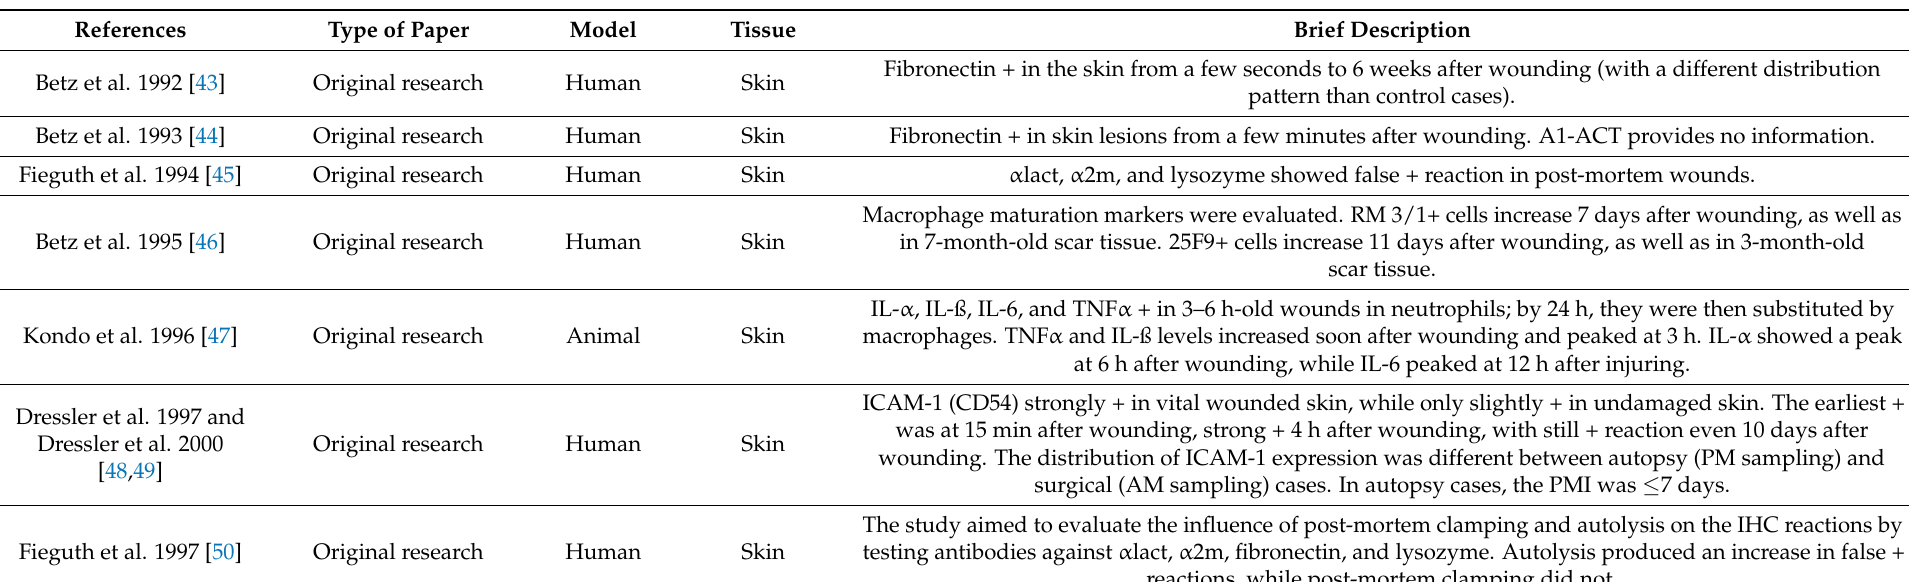
Table 2. The results of our review on immunohistochemical studies on wound vitality (84 articles). * These studies included different kind of analysis to investigate the differential protein expression in tissues, and they have been included in both the relative tables. + indicates positive/positivity; α 7nAChR, α 7 nicotine acetylcholine receptor; α lact, α l antichymotrypsin; α 2m, α 2 macroglobulin; A1-ACT, alpha1-antichymotrypsin; RM3/1, anti-CD163 marker; 25F9, mature macrophages marker; AM, ante-mortem; DC-SIGN, dendritic cell-specific intercellular adhesion molecule-3-grabbing non-integrin; GM-CSF, granulocyte macrophage-colony stimulating factor; GPA, glycophorin A; HSP, heat-shock protein; ICAM-1, intercellular adhesion molecule 1; IHC, immunohistochemistry; IL, interleukin; iNOS, inducible nitric oxide synthase; mAb, monoclonal antibody; MCP, monocyte chemoattractant protein; MHC-II, major histocompatibility complex II; MMP, matrix metallopeptidase; PM, post-mortem; PMI, post-mortem interval; PMNs, polymorphonuclear cells; PTI, post traumatic interval; RAGE, receptor for advanced glycation endproducts; TNF- α , tumor necrosis factor α ; VEGF, vascular endothelial growth factor; VCAM-1, vascular cell adhesion molecule-1; ATP, adenosine triphosphate; TN, tenascin; FN, fibronectin; MRP, myeloid-related protein; FGF, fibroblast growth factor; M-CSF, macrophage colony-stimulating factor; MIG, monokine inducible by interferon gamma; PDGF, platelet-derived growth factor; ORP, oxygen regulated protein; HLA, human leukocyte antigen; TGF, transforming growth factor; MPO, myeloperoxidases; COX, cyclooxygenase; pAb, polyclonal antibody; CB2R, cannabinoid receptor type 2; MNC, mononuclear cell; FBC, fibroblastic cell; SP, surfactant protein; HIF, hypoxia inducible factor; AQ, aquaporin; Cath, cathepsin; MIP, macrophage inflammatory protein; CML, carboxymethyllysine; Flk, receptor for vascular growth factor; EPC, endothelial progenitor cell; TIMP, metallopeptidase inhibitor; Chil, chitinase-like; SMA, smooth muscle actin; FLIP, FLICE inhibitor protein; INF, interferon; Ub,